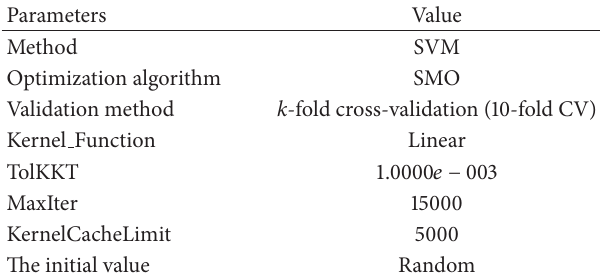
Table 3: Rangevalues and attributenamesfor liver disordersdataset